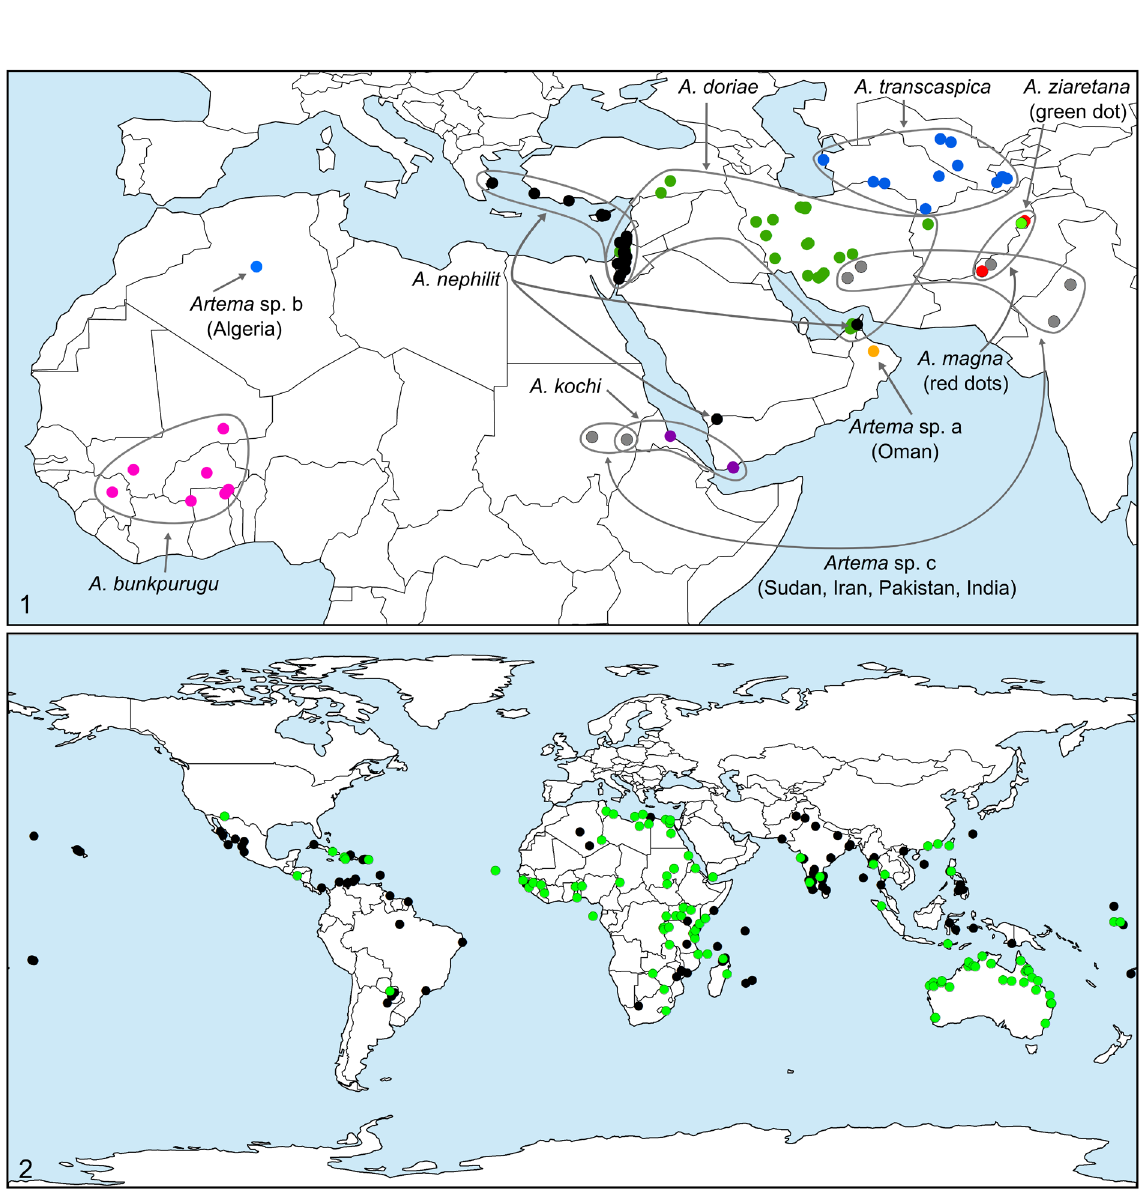
Figs 1–2. 1 . Known distributions of species of Artema except A. atlanta Walckenaer, 1837. The Japanese record of A. doriae Thorell, 1881 is not shown as it is based on a single introduced specimen. 2 . Known distribution of Artema atlanta . Green dots: specimens examined; black dots: specimens not examined (data from: Banks 1898; Beatty et al. 2008; Blackwell 1958; Bösenberg & Lenz 1895; Brignoli 1981; Bryant 1940, 1948; Caporiacco 1928, 1948, 1949; Chamberlin 1924; Chrysanthus 1967; Colmenares 2008; Denis 1953; Doleschall 1857; Dyal 1935; Franganillo 1926a; Gao & Li 2010; Gertsch & Davis 1942; Gonzalez-Sponga 2005; Karsch 1879, 1892; Leardi in Airaghi 1902; Lessert 1936; Majumder & Biswas 1993; Marples 1955; Mello-Leitão 1942; Millot 1946; Moenkhaus 1898; F.O.Pickard-Cambridge 1902; Petrunkevitch 1925, 1929; Pocock 1900; Saaristo 2001; Simon 1885, 1894; Taczanowsky 1874; Thorell 1895, 1898; Vinson 1863; Yaginuma 1970). Records from Israel, Belgium, and Britain are not shown as they are based on single introduced